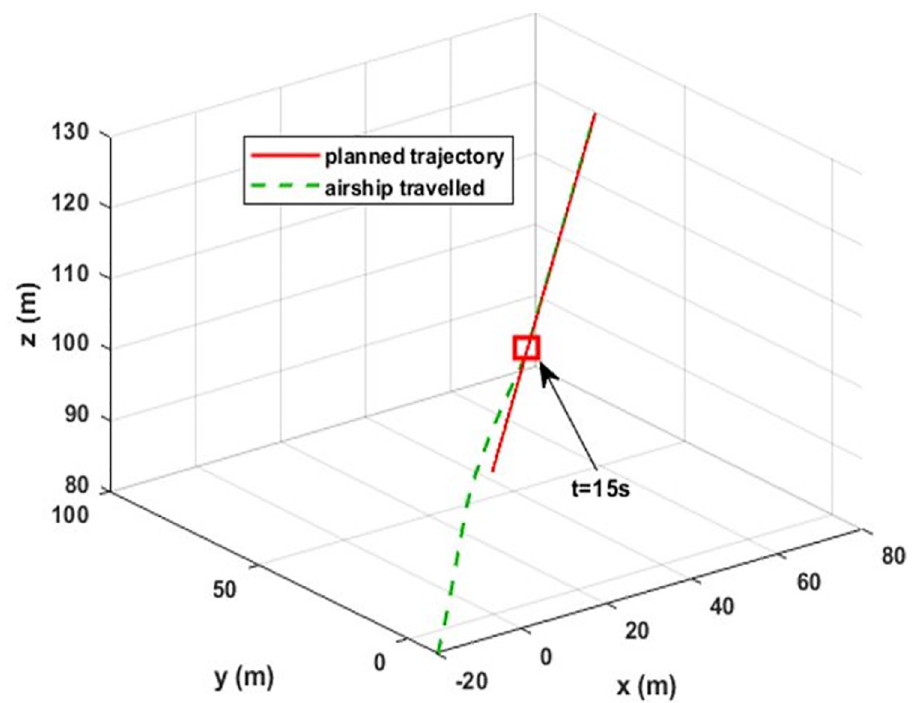
Fig 4. Airship-controlled flight. The dashed green line indicates the actual path traveled by the airship, and the red line shows the desired trajectory. At the 15 sec point, the airship reaches the desired trajectory and starts a steady-state flight. The start of steady-state flight is indicated by a red rectangle.